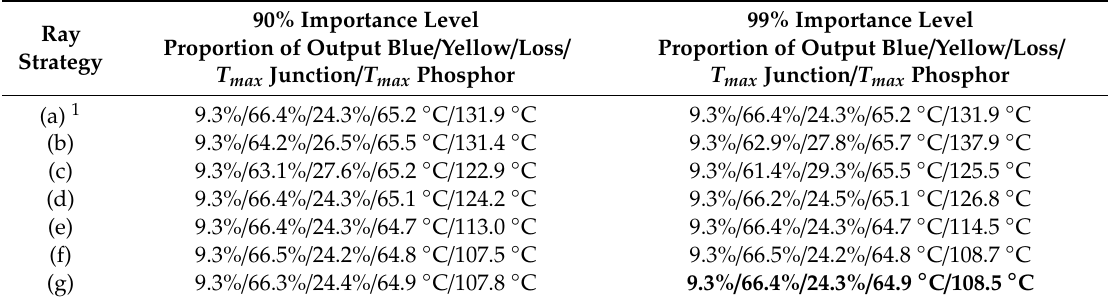
Table 5. Simulation results of the half CoB LED model in the case of 400 mA driving, equal blue and yellow absorption, 90% and 99% importance levels, five blue rays / junction.